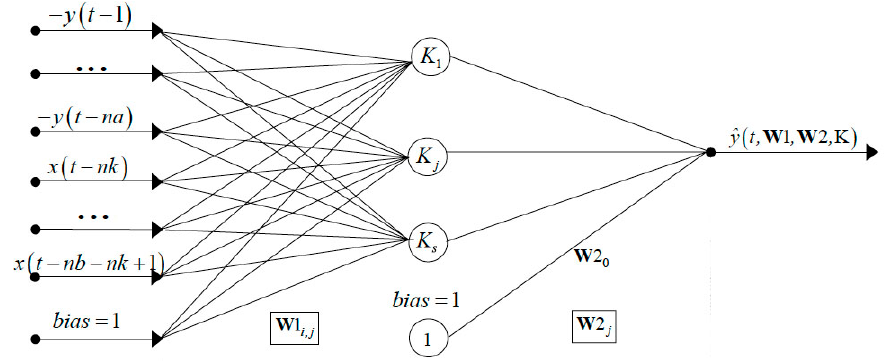
Figure 1. IODNN with an ARX regressor [45].